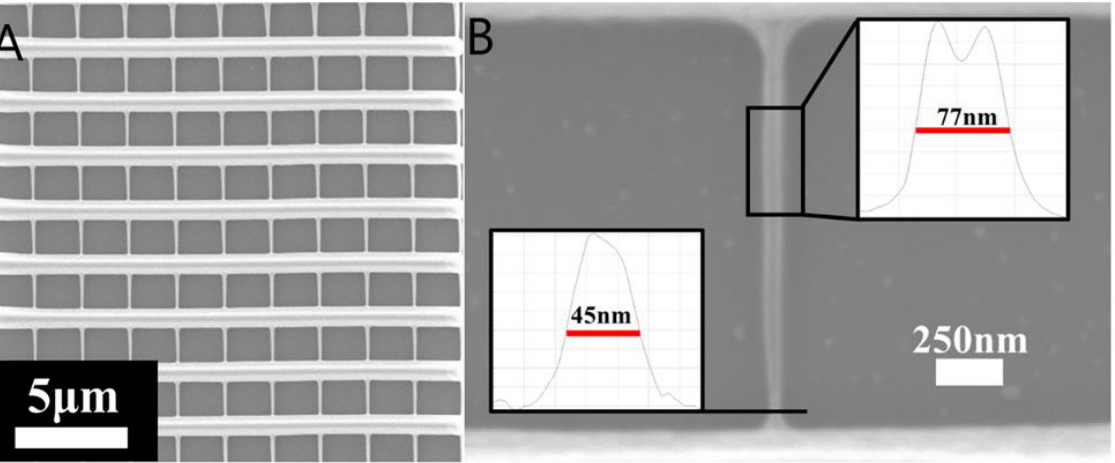
Figure 13. ( A ) SEM image of the structure with percolation lines (vertical). ( B ) SEM image of the percolation line with the smallest size. The insets show the electron scattering intensity profiles for the selected region.